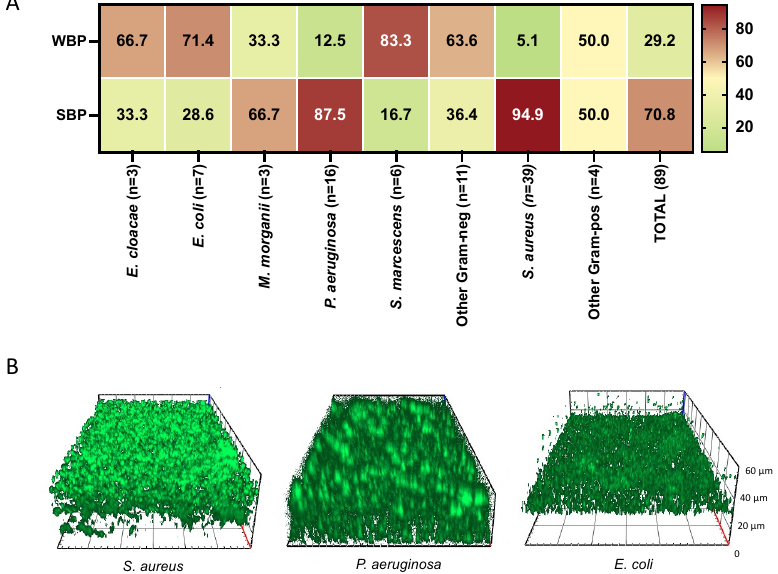
Figure 2. Biofilm production of bacterial isolates from patients with infected chronic venous leg ulcers. ( A ) Biofilm formation was assessed by the cBRT. Clinical isolates were classified as strong biofilm producers (SBPs) and weak biofilm producers (WBP). All results are expressed as a percentage. ( B ) Representative images of Staphylococcus aureus , Pseudomonas aeruginosa, and Escherichia coli isolates grown for 24 h at 37 °C. Orthogonal sections displaying horizontal and side views of reconstructed three-dimensional (3D) biofilm images are shown.